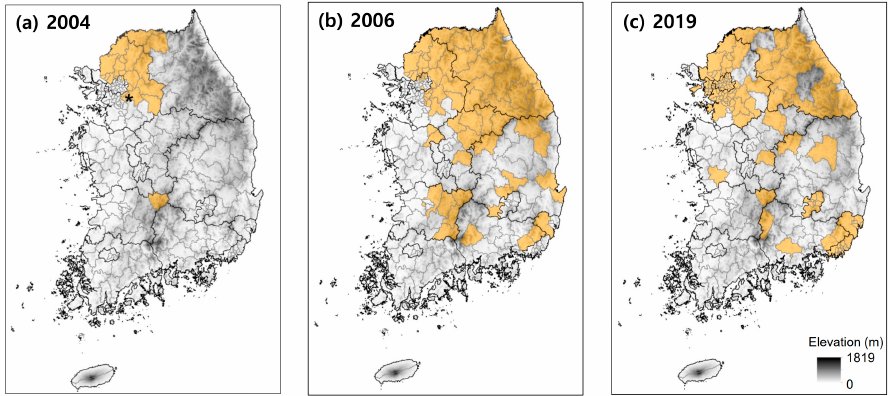
Figure 1. The occurrence areas (yellow color) of KOW in 2004 ( a ), 2006 ( b ) and 2019 ( c ) in South Korea. The asterisk indicates the first occurrence area (i.e., Ibaejae in Seongnam, South Korea) of KOW reported in 2004. The gray color indicates elevation. The graphs were drawn based on data from Annual Report of Monitoring for Forest Insect Pests and Diseases in Korea [18] .